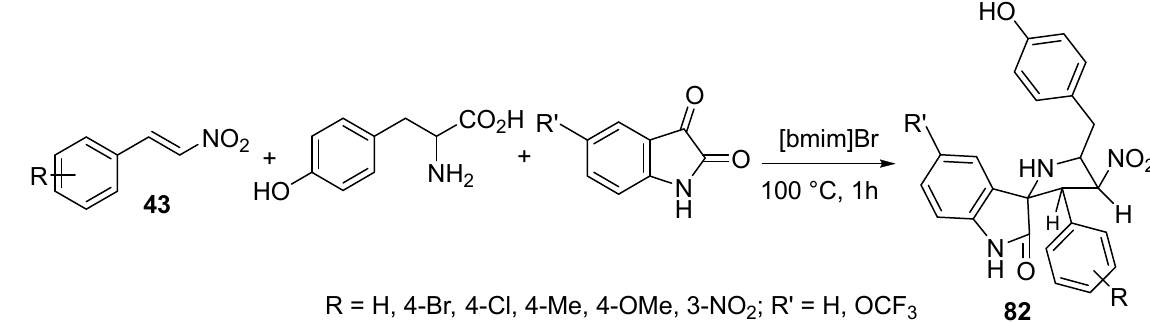
Ionic liquid [bmim]Br, mediated (100 °C) azomethine (formed from the condensation